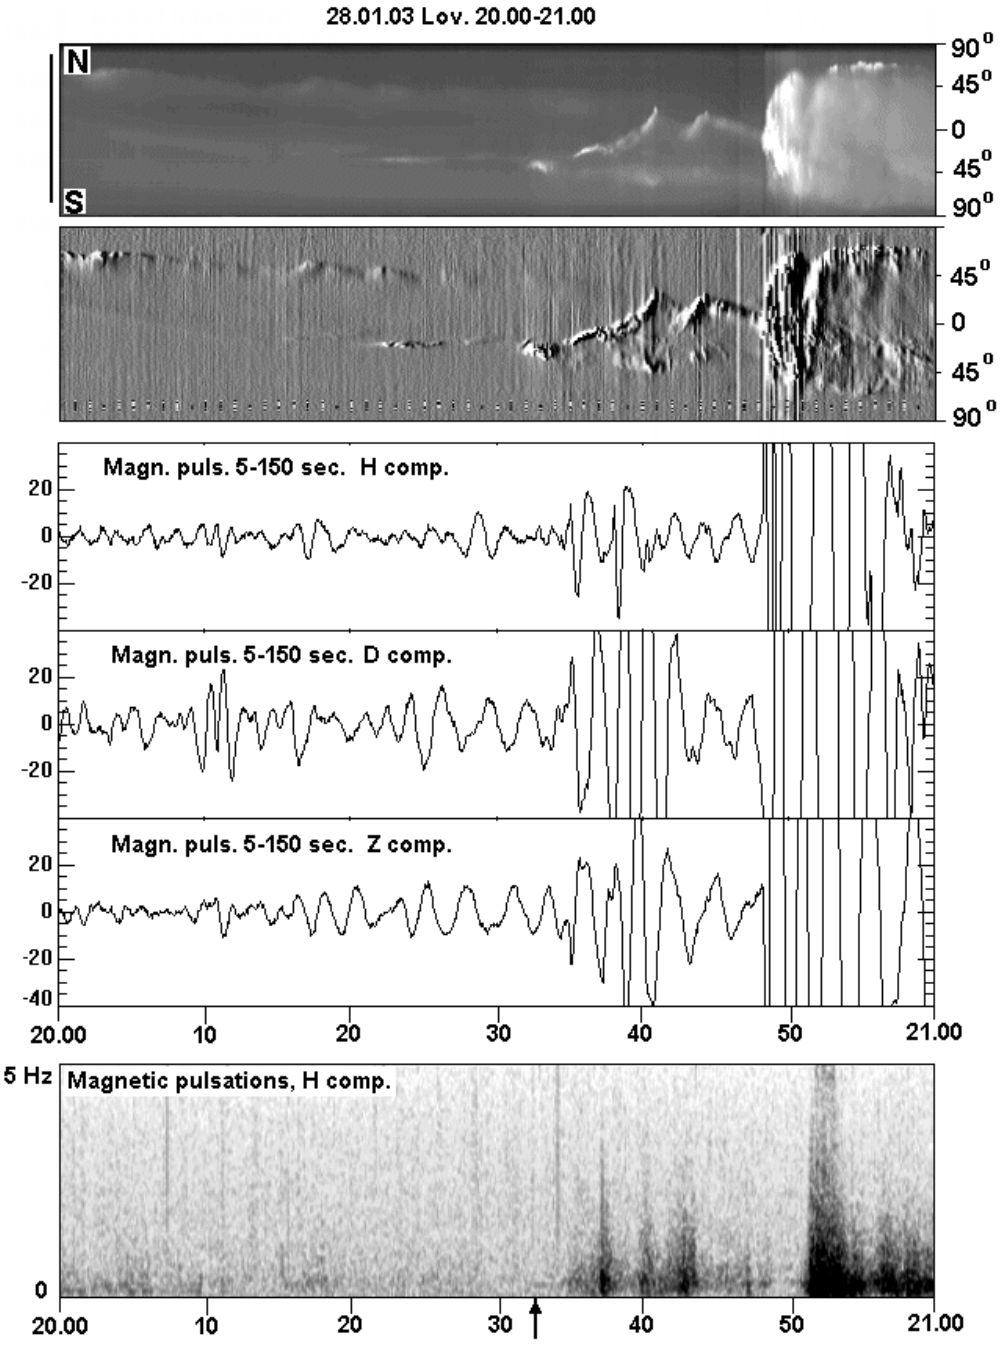
Fig. 5. Standard and filtered keograms of analyzed event and magnetometer